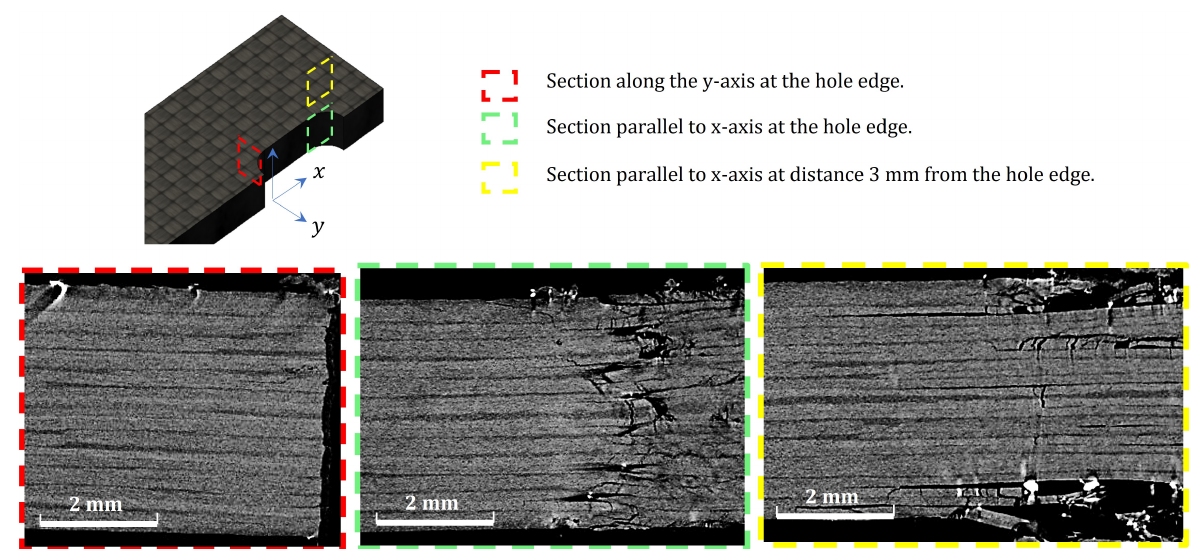
Figure 7. Computed Tomography scan of the baseline